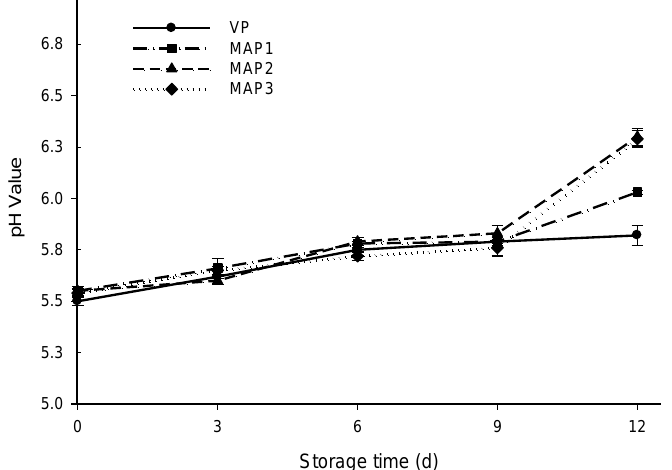
Figure 1. Effect of gas composition in modified atmosphere packaging on pH value of Longissimus dorsi of Korean Native Black Pig crossbred with Duroc during refrigerated storage. VP, vacuum packaging; MAP, modified atmosphere packaging. MAP1 = 0:20:80/O 2 :CO 2 :N 2 , MAP2 = 30:20:50/O 2 :CO 2 :N 2 , MAP3 = 70:20:10/O 2 :CO 2 :N 2